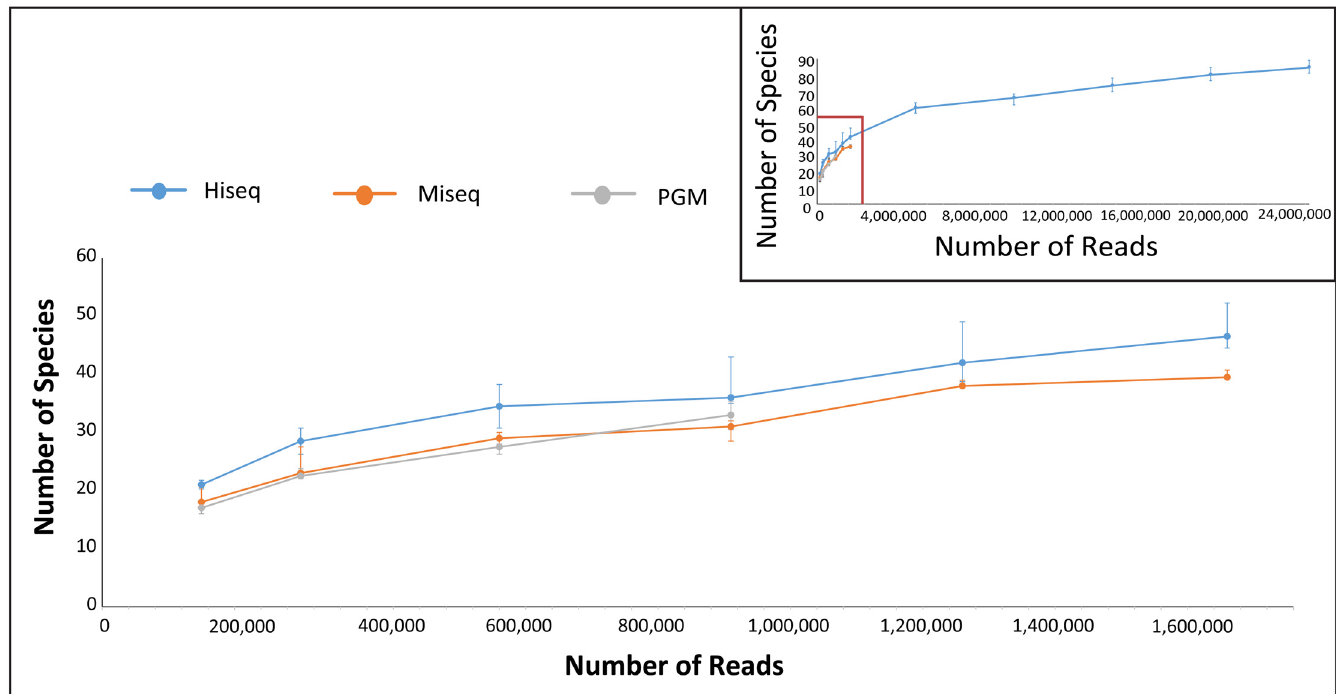
Fig 5. Number of species observed from randomly subsampled reads using MetaPhlAn2. Each point represents the median value across each of the 6 samples per technology (including 3 replicates per sample). Error bars are the 25% and 75% quartile ranges.